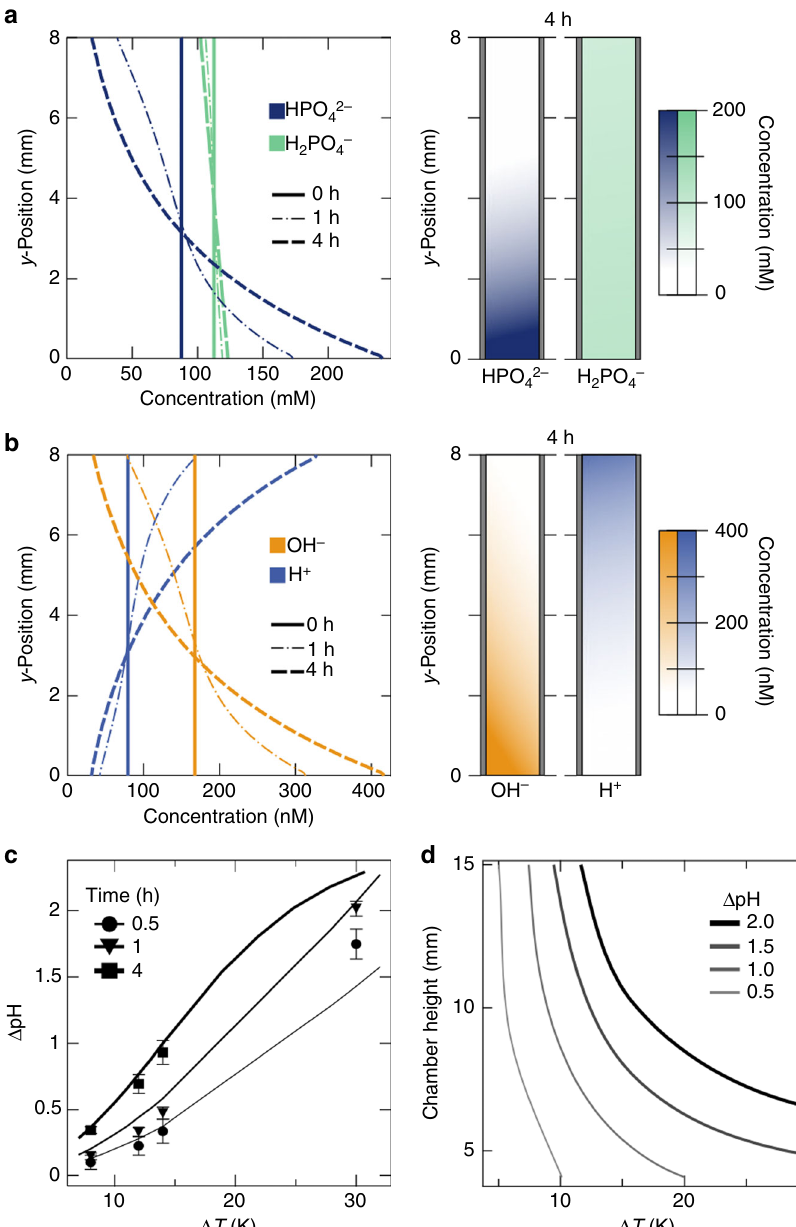
Fig. 3 Accumulation of phosphate buffer species imbalances the reaction equilibrium. a Each phosphate species accumulates at the bottom of the chamber, depending on its thermophoretic force. At near neutral pH, HPO 4 2 − and H 2 PO 4 − are predominately in the solution. As the thermophoretic force scales with the charge of the molecules squared, HPO 4 2 − achieves a tenfold higher accumulation compared to H 2 PO 4 − . b The protonation reaction of HPO 4 2 − reduces the hydronium ion concentration at the bottom of the chamber while the deprotonation reaction of H 2 PO 4 − simultaneously releases hydronium ions at the top. The system reaches its steady state on the order of hours. c The pH gradient scales approximately linearly with the applied temperature difference. A maximum proton gradient of Δ pH = 2.1 is formed for Δ T = 30 K. d An elongated fl ow chamber compensates for lower temperature differences, achieving similar or higher pH gradients. The error bars give the standard deviation of the SNARF-1